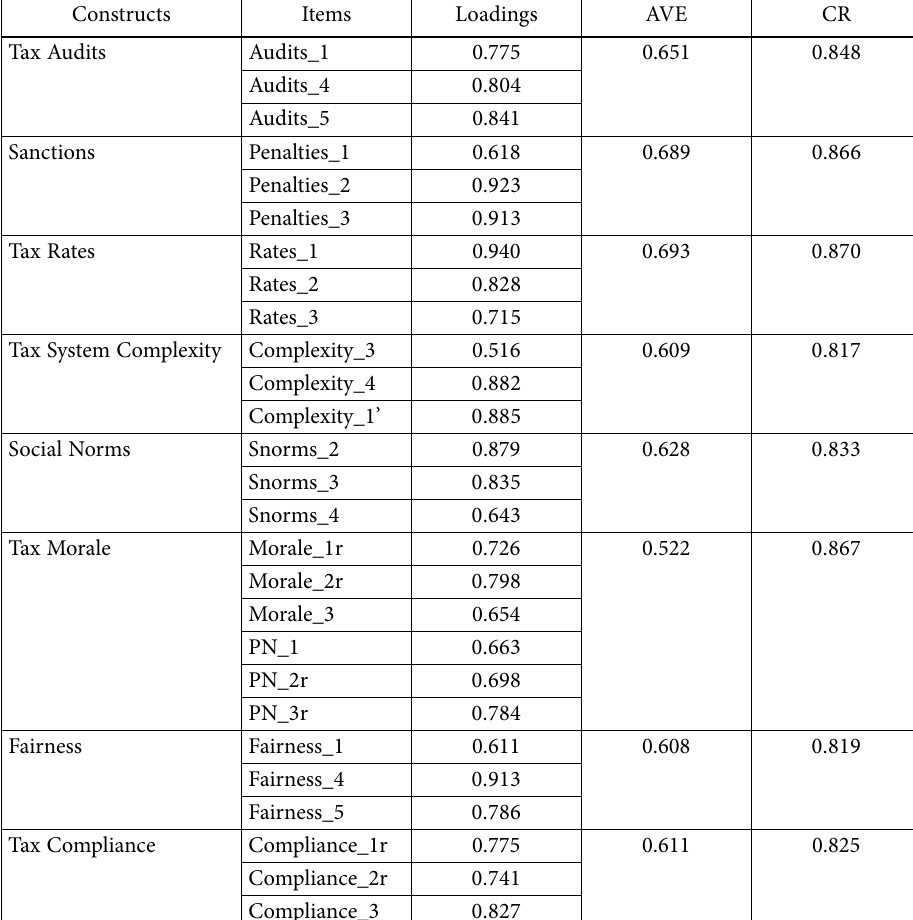
Table 3. Validity and reliability for